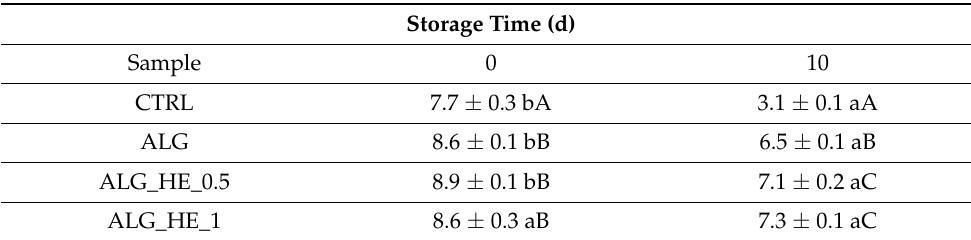
Table 3. Appearance scores of samples analyzed (mean ± sd; n =